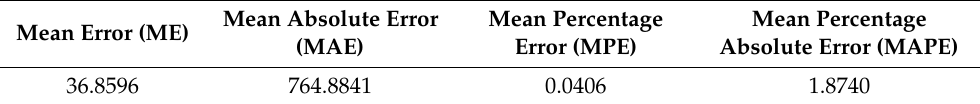
Mean error indicates a slight positive deviation from zero. This means that the obtained forecasts are slightly underestimated. Mean absolute error indicates that actual oil